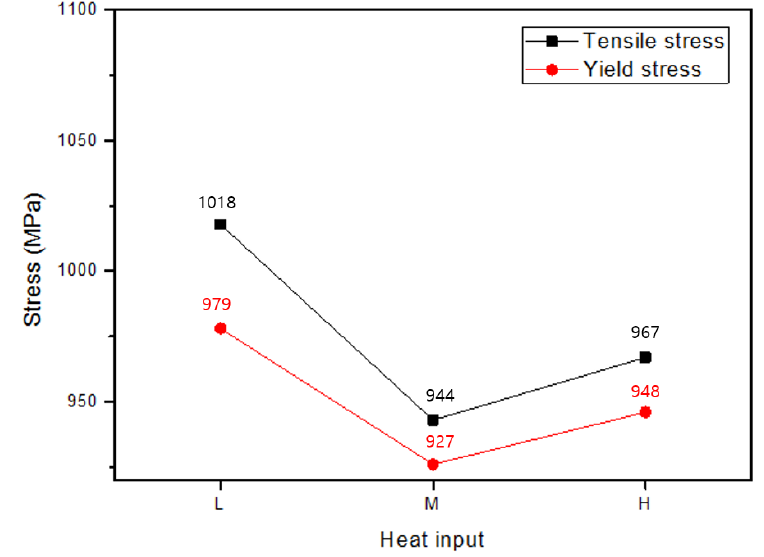
Figure 18. Tensile test results of FCAW with CO 2 100% shielding gas and heat input.